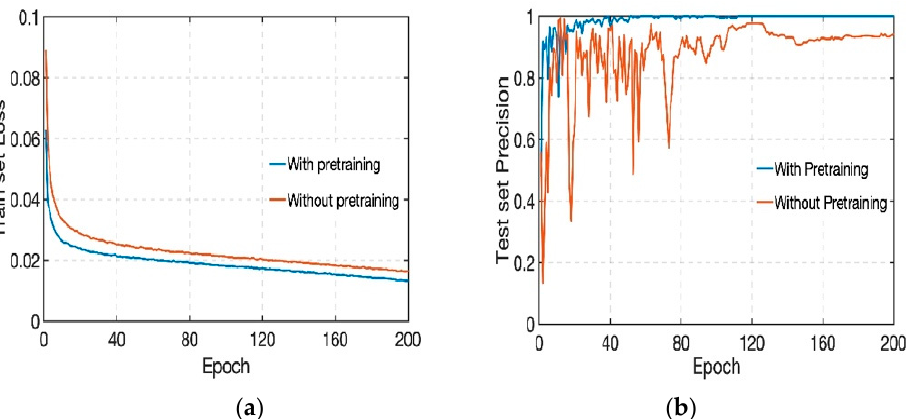
Figure 6. Training loss values ( a ) and test precision values ( b ) for each epoch. The different color of the curve represents whether pre-training is used or